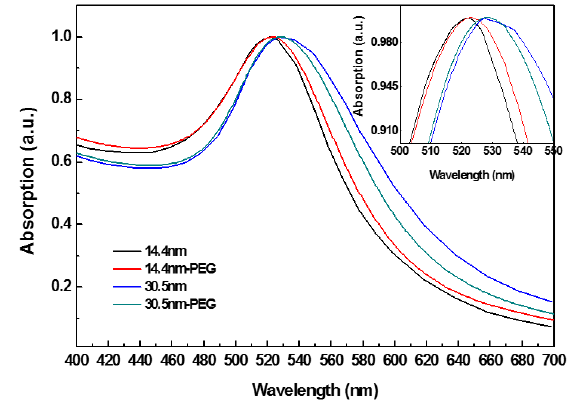
Figure 1. The optical absorption of polyethylene glycol (PEG)-coated gold nanoparticles (GNPs).